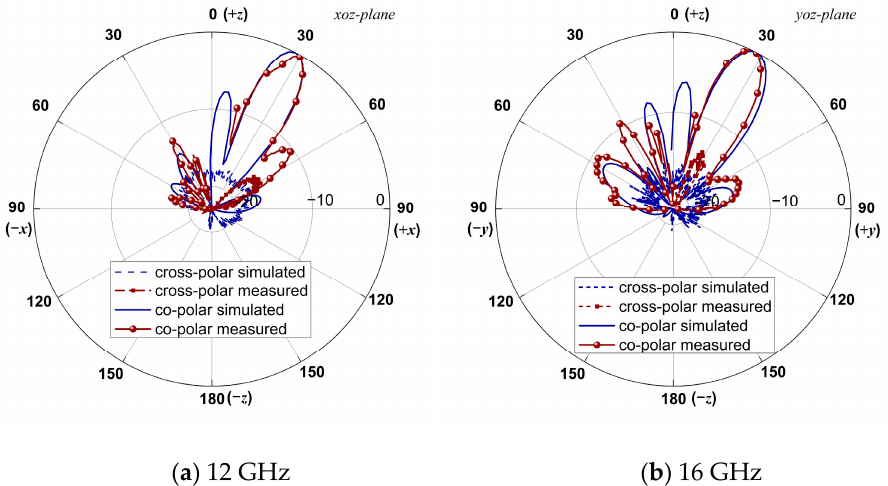
Figure 7. Scattering pattern of 11 × 7 element reflectarray. ( a ) 12 GHz. ( b ) 16 GHz.